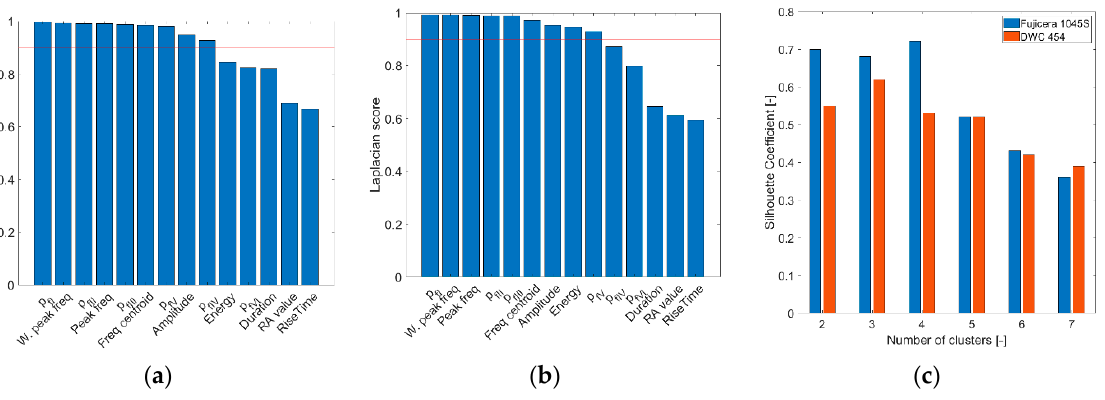
Figure 9. Laplacian score results from the ( a ) Fujicera 1045S and ( b ) DWC 454 sensors; ( c ) silhouette coefficient.